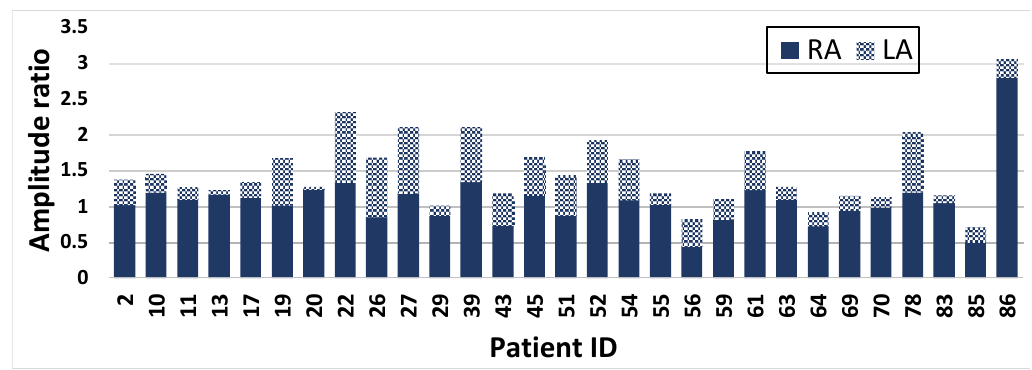
Figure 6. Patients with the RA potential higher than the LA potential. The average of three peak to peak amplitudes of the RA and the LA are measured respect with lead II.